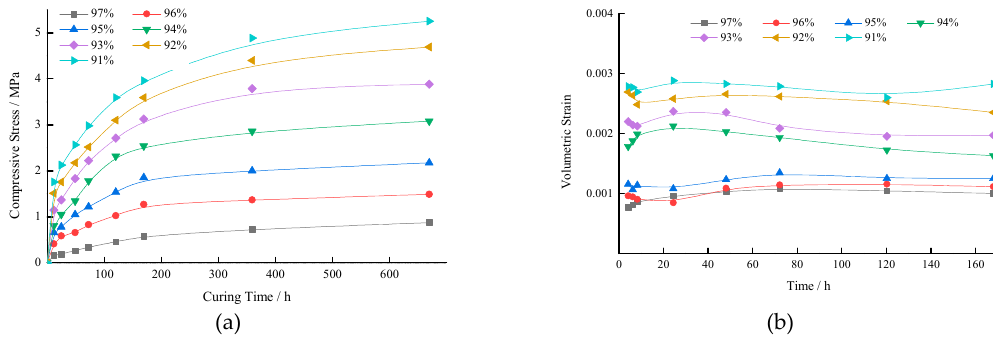
Figure 8. Compressive strength and volumetric strain of high-water-content backfill materials. ( a ) Compressive strength and ( b ) Volumetric strain.